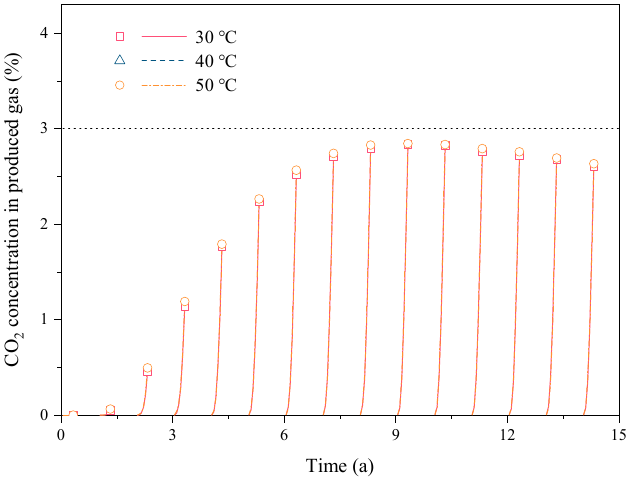
Figure 14. Thickness of the mixed zone for different temperature.